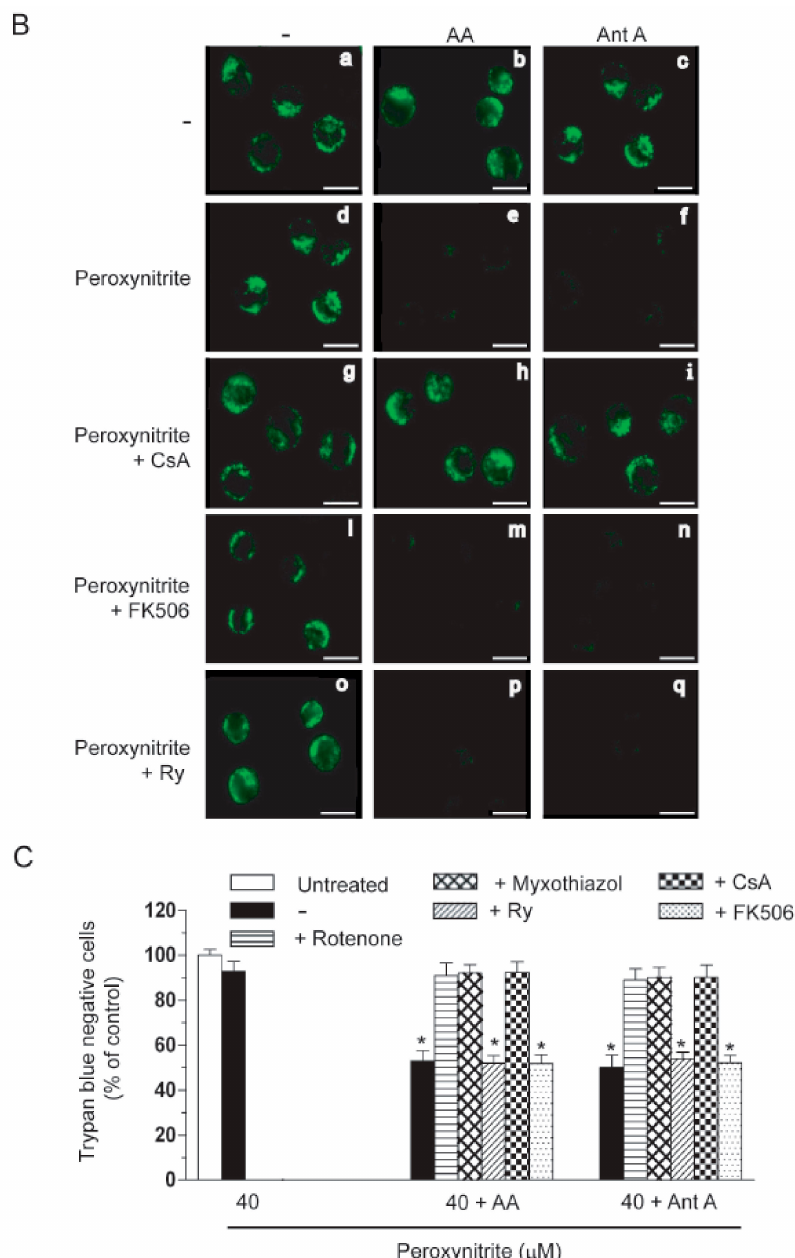
Figure 3. AA enhances the lethal response mediated by peroxynitrite in U937 cells via a mitochondrial permeability transition (MPT)-dependent mechanism uniquely sensitive to rotenone, myxothiazol or CsA. ( A ) U937 cells were pre-exposed for 15 min to AA, or for 5 min to antimycin A (Ant A), and then treated for 10 min with 40 µ M peroxynitrite. In some experiments, rotenone, myxothiazol, Ry, CsA (0.5 µ M) and FK506 (1 µ M) were given to the cultures prior to peroxynitrite. After treatments, the cells were analyzed for MitoTracker red CMXRos-fluorescence; ( B ) representative micrographs of U937 cells loaded for 15 min with 1 µ M calcein-acetoxymethyl ester and 1 mM CoCl 2 , washed and then post-incubated for a further 10 min with or without peroxynitrite, alone or associated with the additions indicated in the figure. The micrographs are representative of at least three separate experiments. Scale bars represent 20 µ m; ( C ) cells were treated as detailed in ( A ) and then exposed for 60 min to peroxynitrite. After treatments, the cells were analyzed for toxicity with the trypan blue exclusion assay. Results represent the means ± SD calculated from at least three separate experiments. * p < 0.001 as compared to untreated cells (one-way ANOVA followed by Dunnett’s